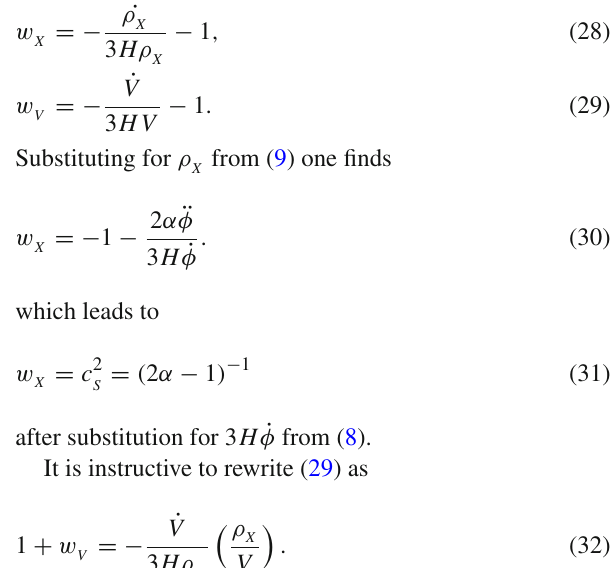
Fig. 3 The evolution of density parameters (Ω i = ρ i /ρ cr ) is shown for radiation (red), baryons (dotted green), kinetic term ρ green) and the potential V (φ) (solid blue) for V (φ) ∝ coth 2 φ . This model gives rise to a matter dominated epoch (sourced by the kinetic term ρ ) when z > 1 and a DE dominated epoch, sourced by the X potential V (φ) , when z < 1 w φ ( z = 0 ) (cid:2) − 0 . 7292